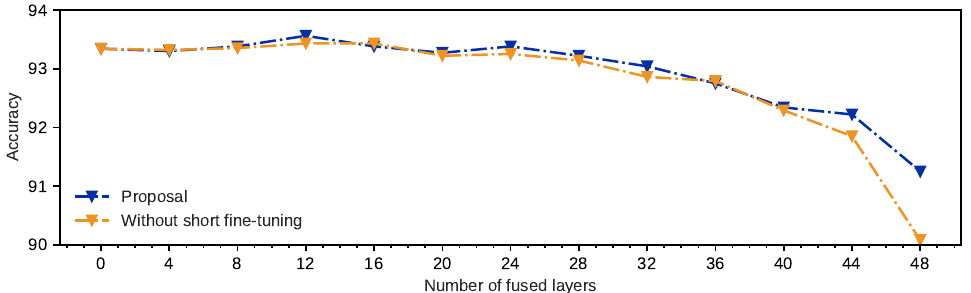
Figure 5. Details of the layer-fusion experiment on ResNet-110 without short fine-tuning. Table 5. Accuracy of the compressed models and models trained from scratch with compressed ar- chitectures.